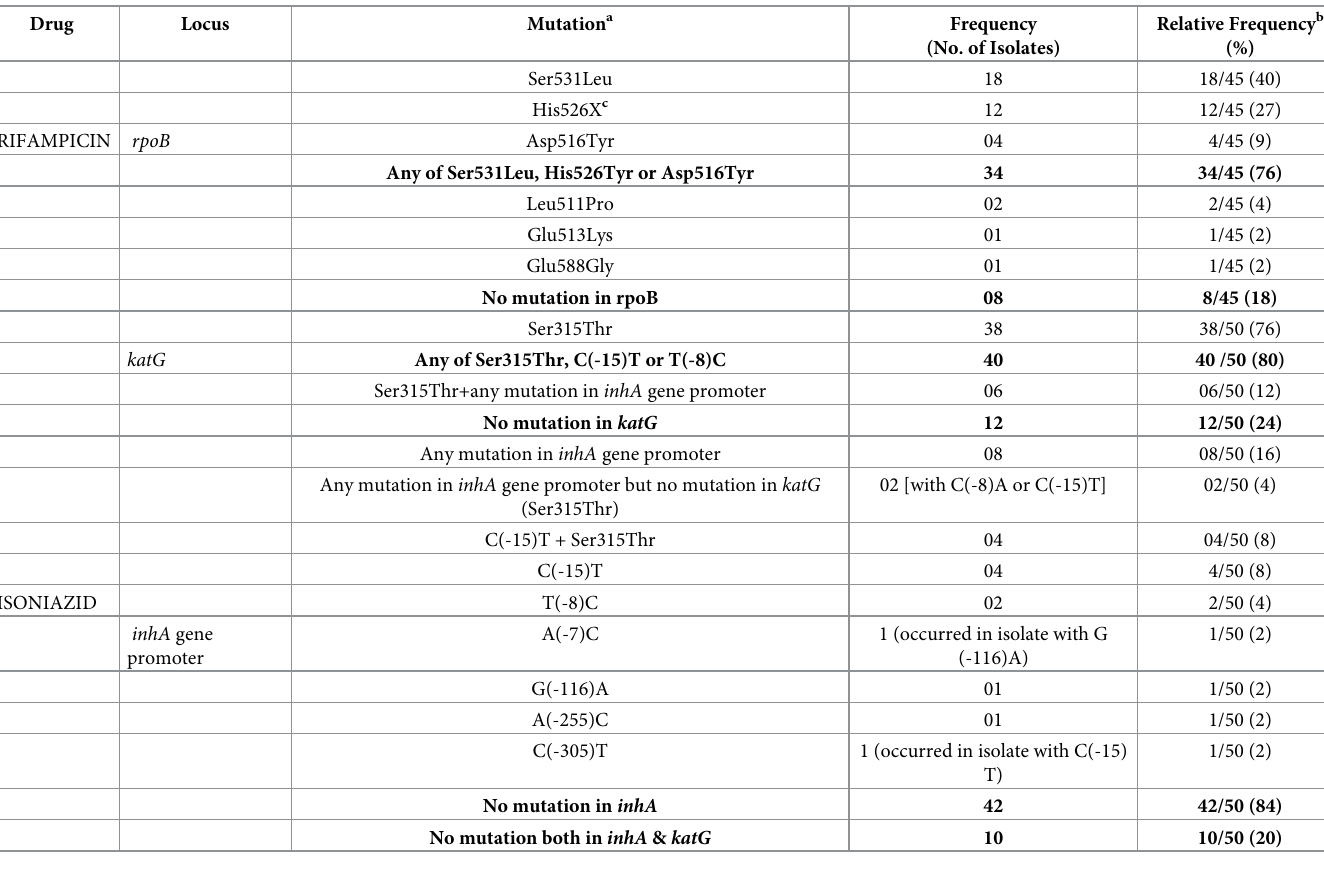
Table 1. Frequency and patterns of resistance conferring mutations in M . tuberculosis isolates that were resistant to rifampicin (n = 45) and isoniazid (n = 50).